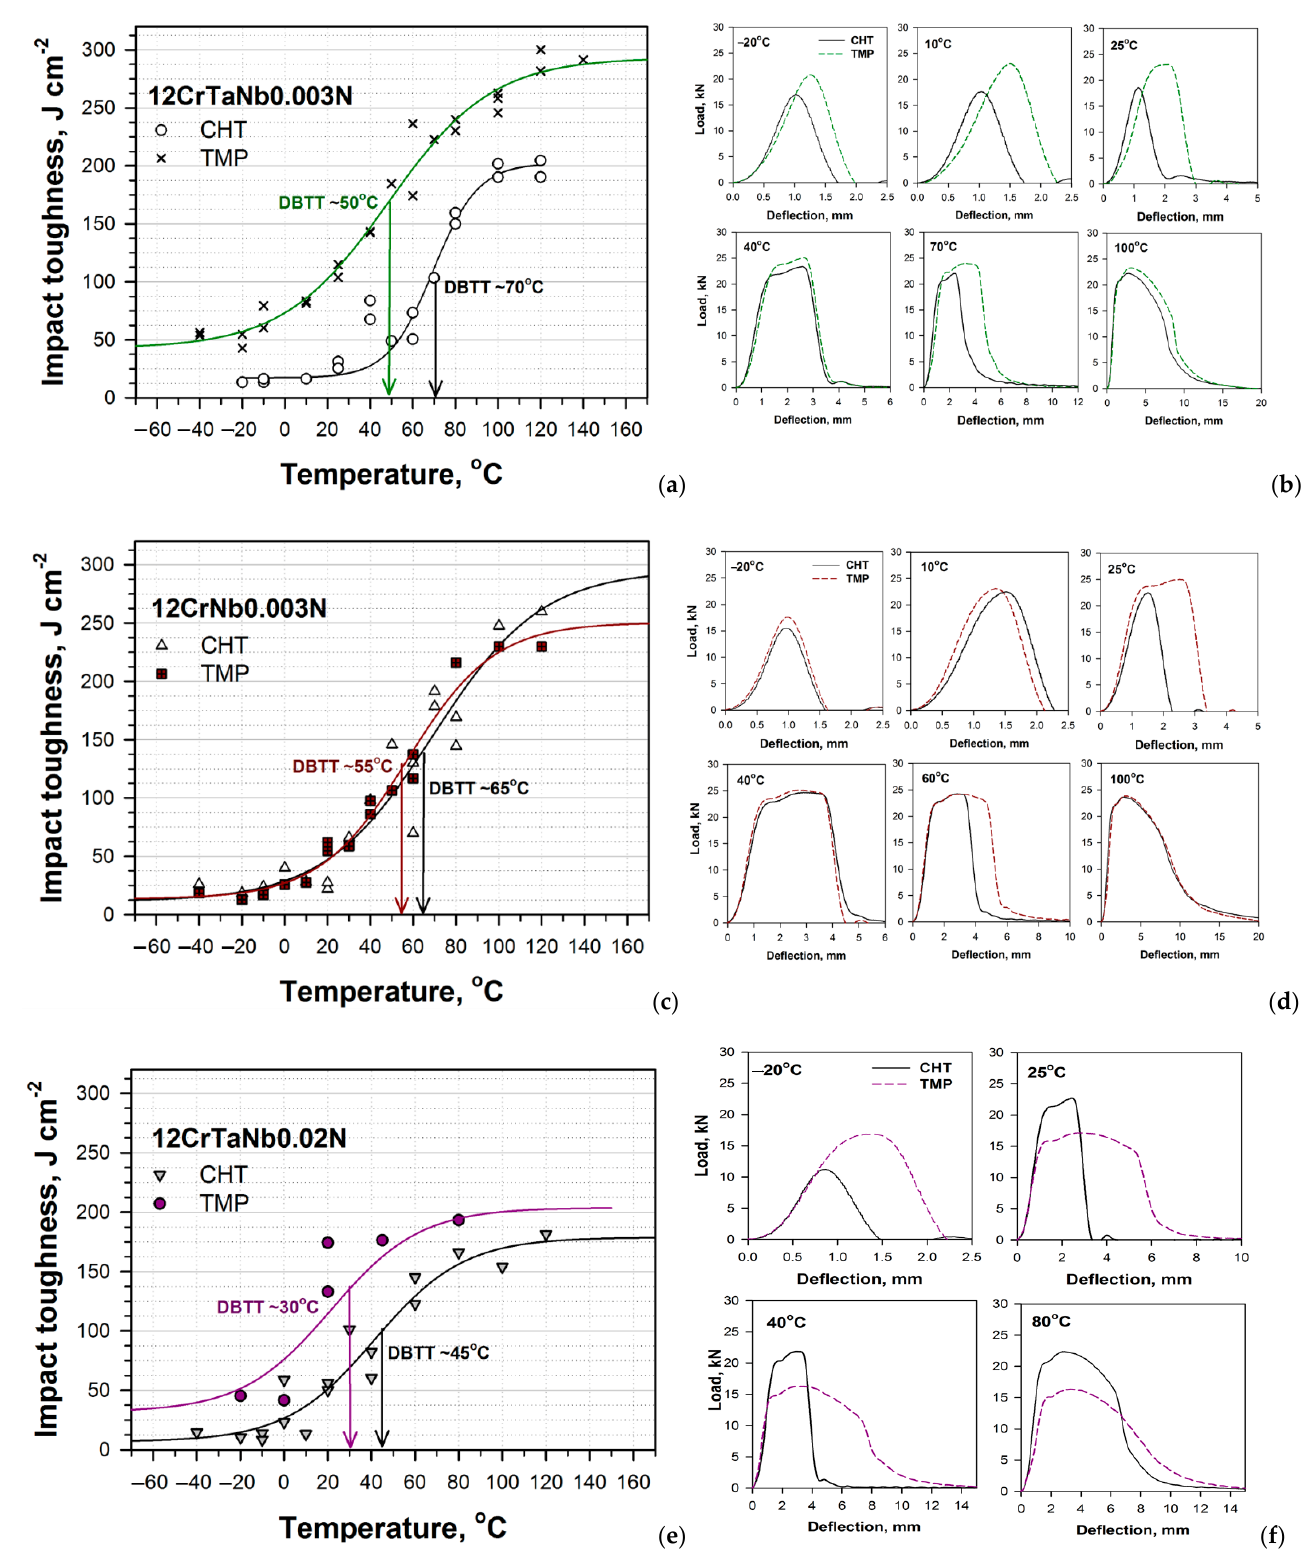
Figure 2. The temperature dependence of Charpy energy ( a , c , e ) together with “load vs. deflection” curves at different test temperatures ( b , d , f ) for the 12CrTaNb0.003N ( a , b ), 12CrNb0.003N ( c , d ), and 12Cr- TaNb0.02N ( e , f ) steels subjected to the CHT and TMP. DBTT means ductile-brittle transition